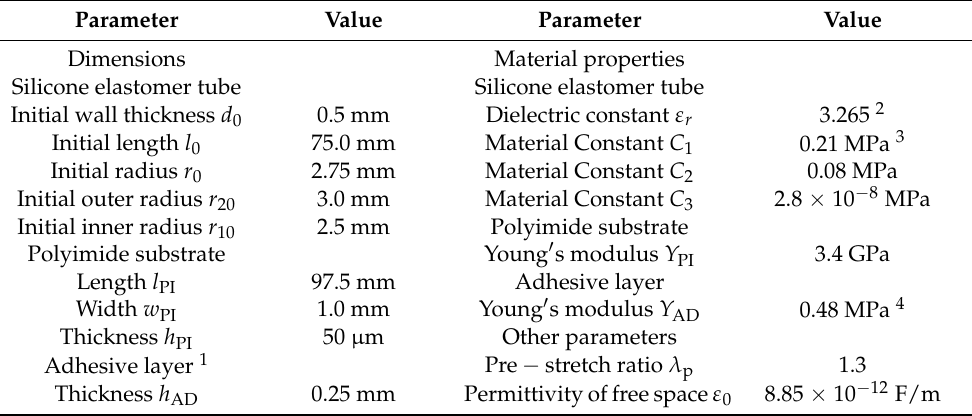
Table 1. Model parameter of